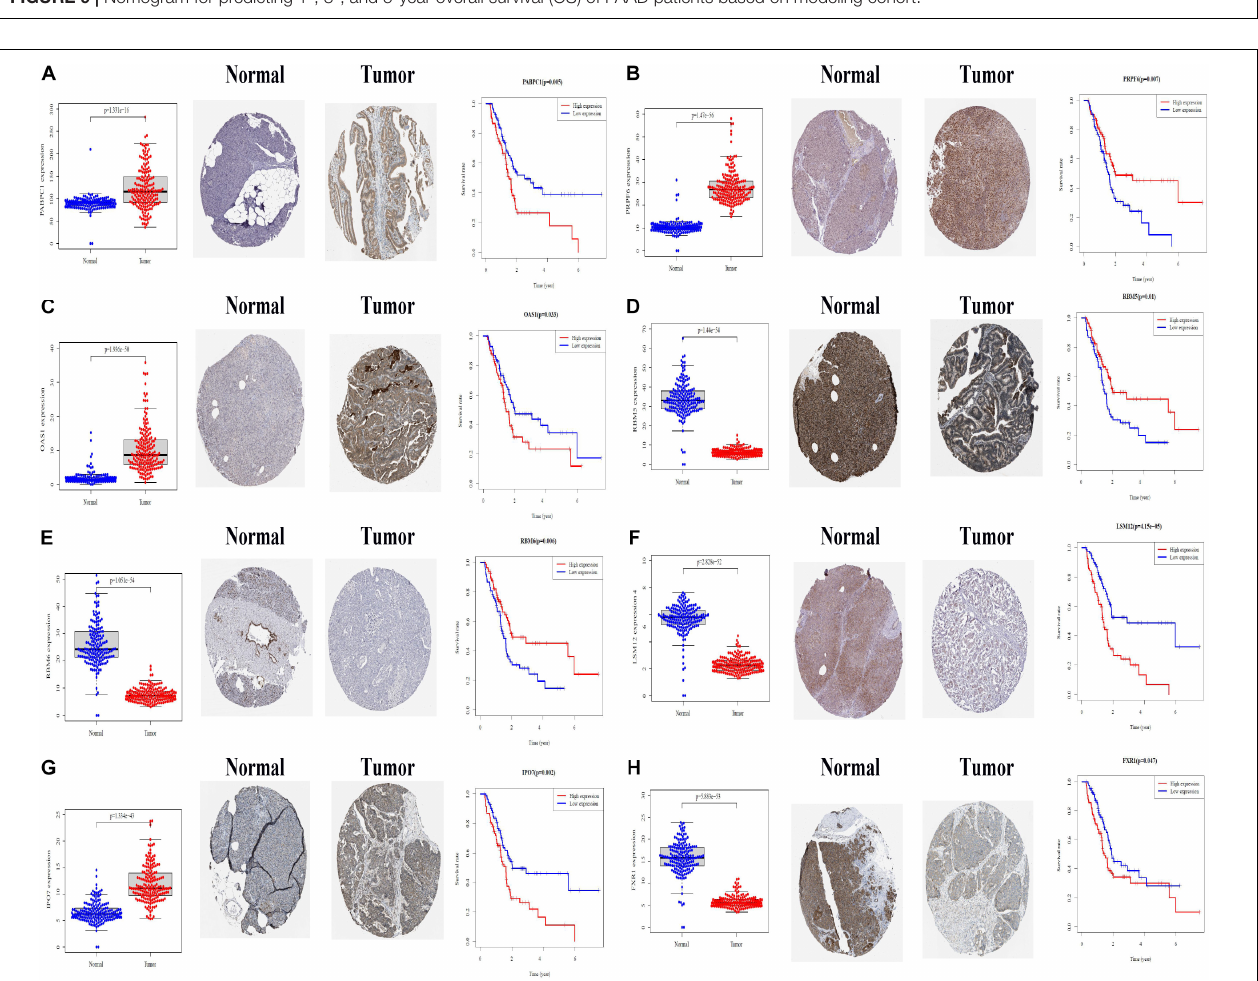
FIGURE 10 | Differential expression and Kaplan–Meier survival curves of eight modeling RBPs in PAAD based on TCGA, HPA, and KM-PLOT databases. (A) PABPC1; (B) PRPF6; (C) OAS1; (D) RBM5; (E) RBM6; (F) LSM12; (G) IPO7; (H) FXR1. P < 0.05 is considered significantly.